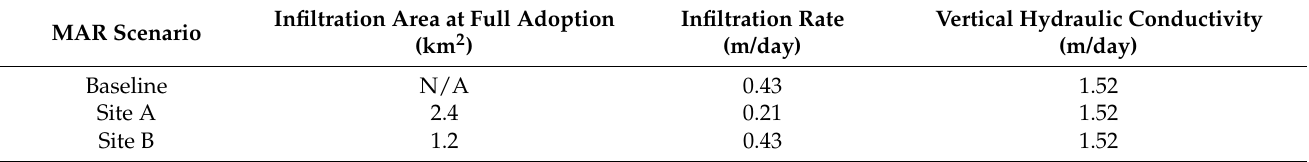
Table 1. Parameter values for baseline in single drought analysis and for infiltration sites A and B in multi-year droughts analysis. MAR